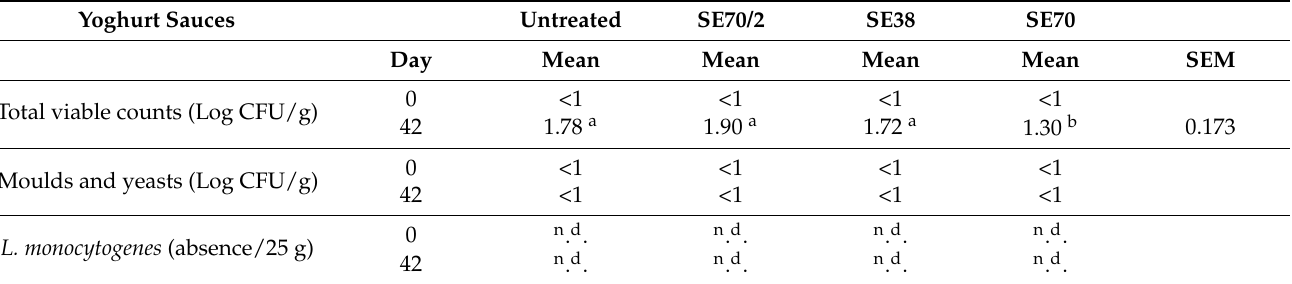
Table 3. Microbial quality of yoghurt sauces enriched with sage extracts (SE70/2, SE38, and SE70) and kept at 4 ◦ C for 42